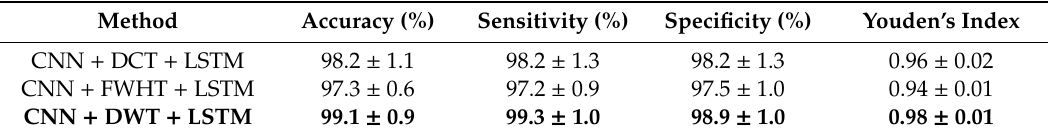
Table 4. Application of di ff erent discrete transform methods in the proposed method.